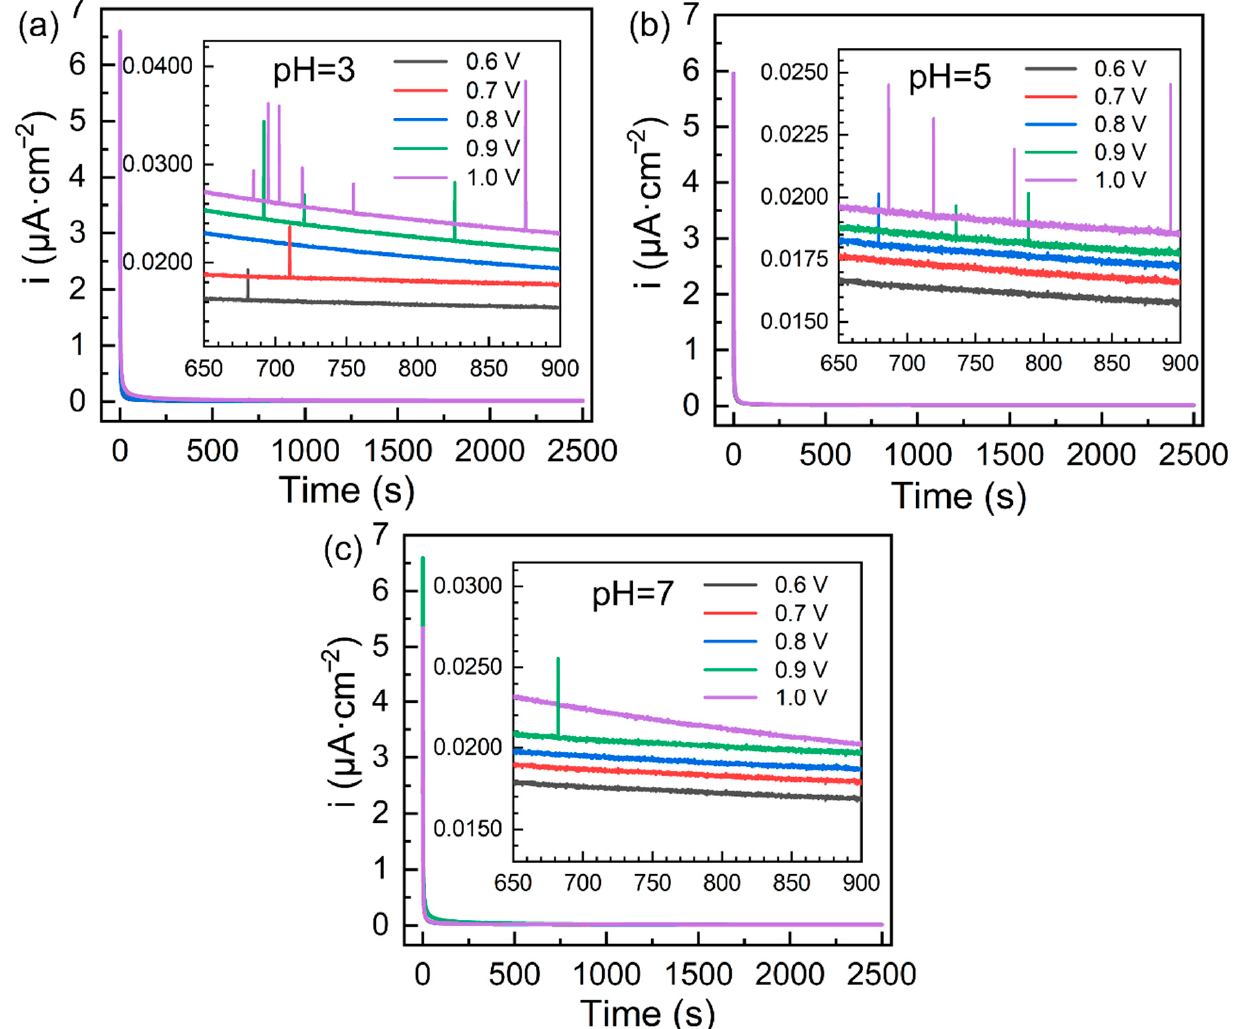
Figure 3. Potentiostatic polarization curves of LPBFed Ti–6Al–4V in Hank’s solution at ( a ) pH 3; ( b ) pH 5; and ( c ) pH 7, under 0.6, 0.7, 0.8, 0.9, and 1.0 V SCE . The enlarged regions from 650 to 900 s are shown in the insets.